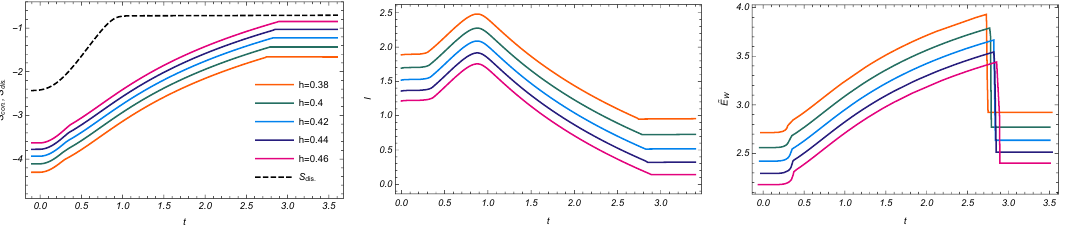
Figure 16 . The HEE (left), HMI (middle) and EWCS (right) as functions of boundary time for di(cid:11)erent values of the separation between subregions in an extremal black brane geometry. The connected con(cid:12)guration is always favored for any boundary time and EWCS saturates to a (cid:12)nite value. Here we have set ‘ = 1 : 18 ; v 0 = 0 : 001 and d =